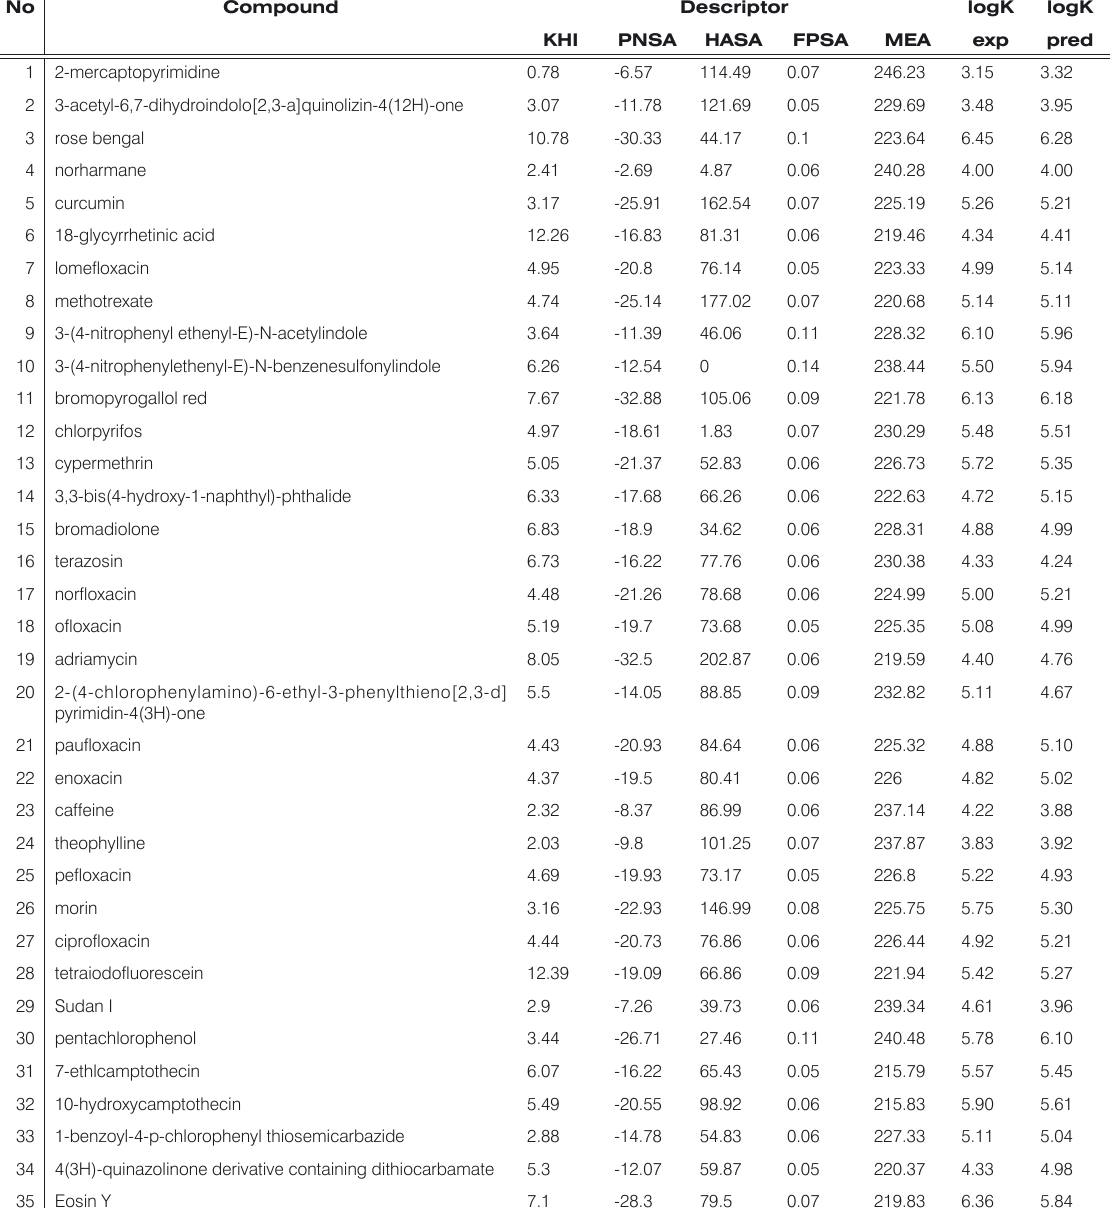
Table 1. Compounds, Descriptors value, Experimental and Predicted log K